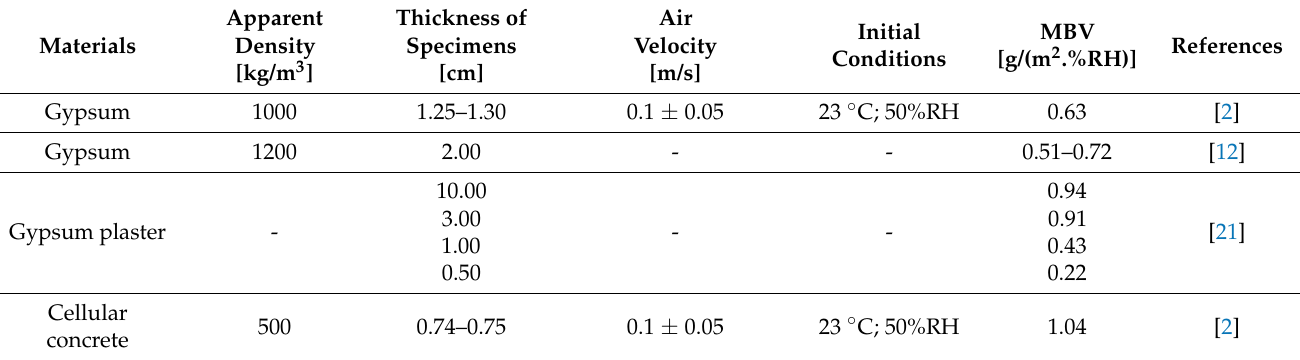
Table 1. Summary of the different parameters, dynamic solicitations and MBVs for different materials presented in the